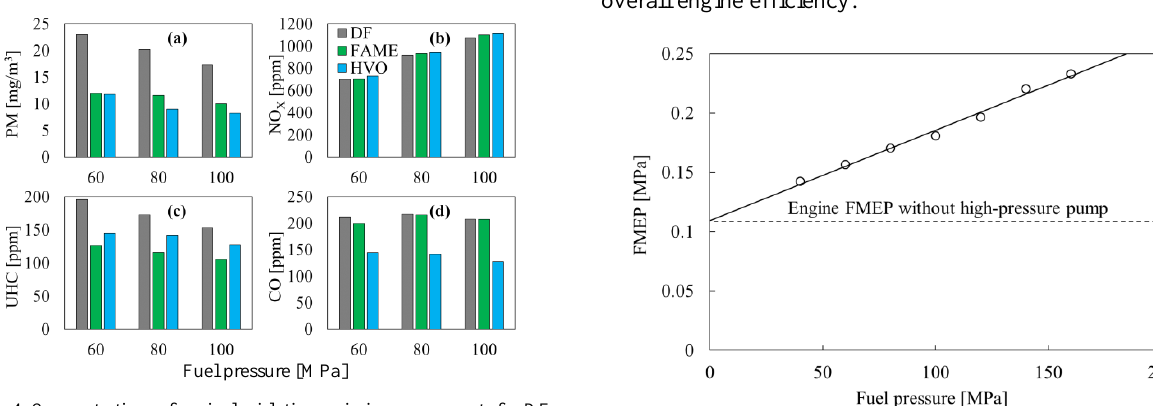
Fig. 4. Concentrations of major legislative emission components for DF, FAME and HVO; rail pressure sweep Fig. 5. Effect of fuel pressure on friction mean effective pressure of the engine at constant IMEP of 0.5 MPa; DF reference Discussion of Fig. 5 explains this issue on the basis